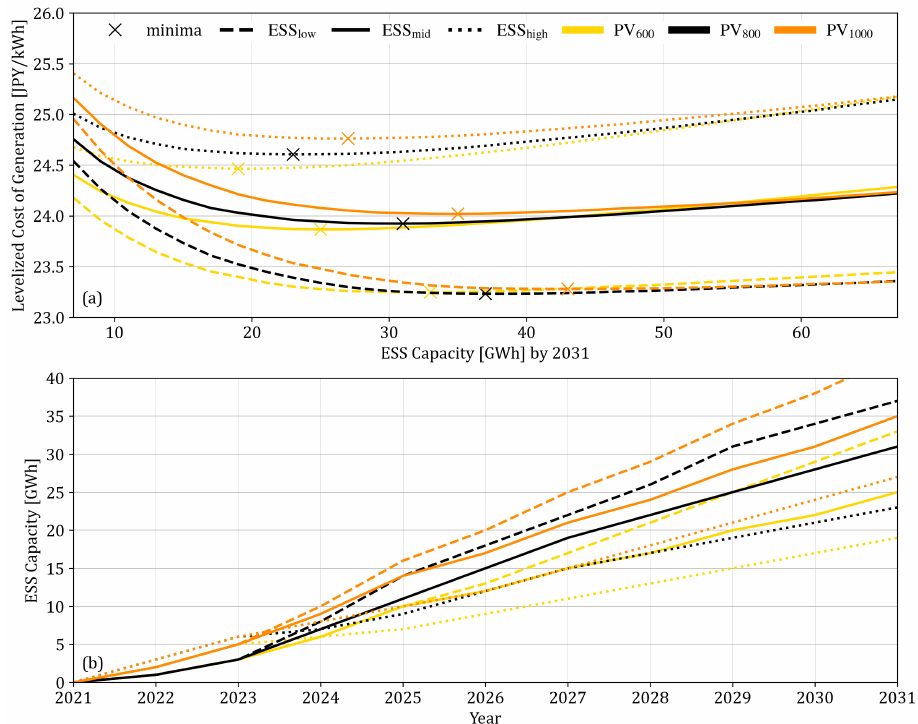
Figure 14. Impact of the solar capacity growth rate and ESS unit cost on ( a ) LCOG trend line and ( b ) the cost-optimal growth trajectory. Convention: the color of the line represents the solar capacity growth rate, while the line style represents the project ESS unit